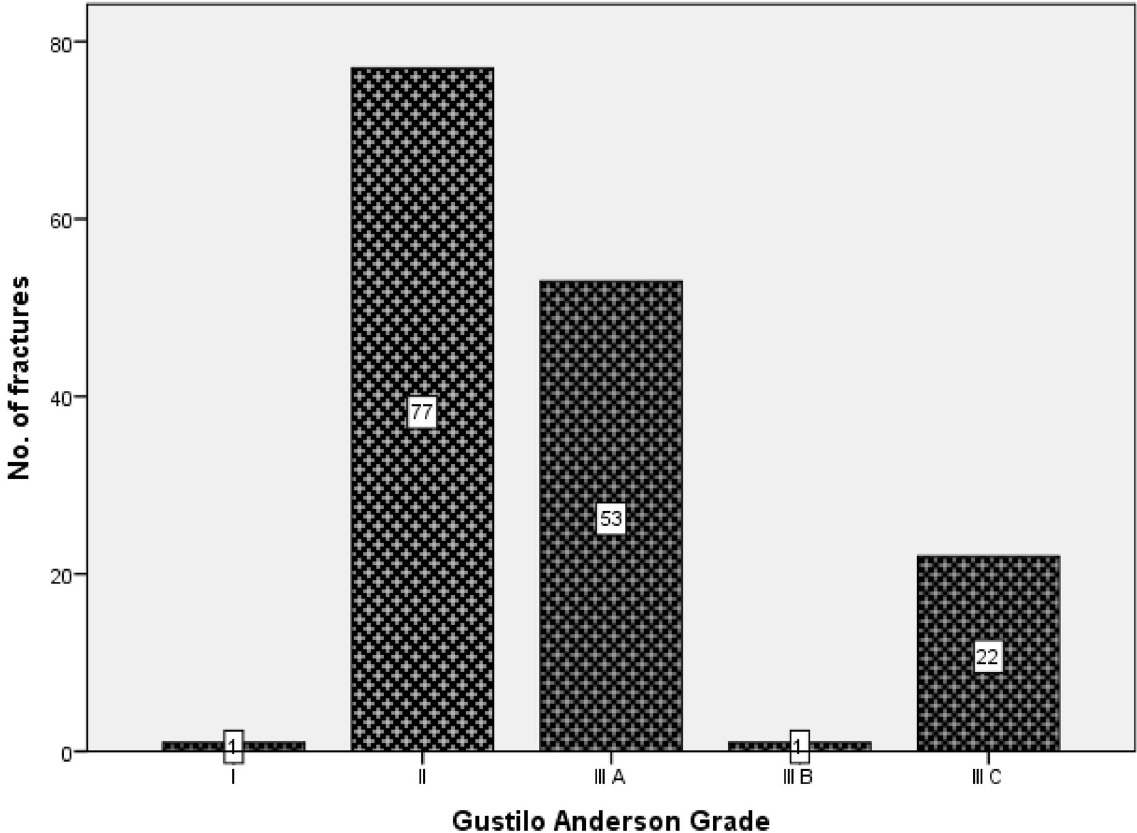
Figure 1. Distribution of 154 machete cut fractures by Anderson and Gustilo Classification. Figure designed using IBM Statistical package for Social Sciences, IBM SPSS Statistics version 20 (IBM Corp. Armonk, N.Y. USA) statistical soft ware https ://www.ibm.com/produ cts/spss-stati stics .